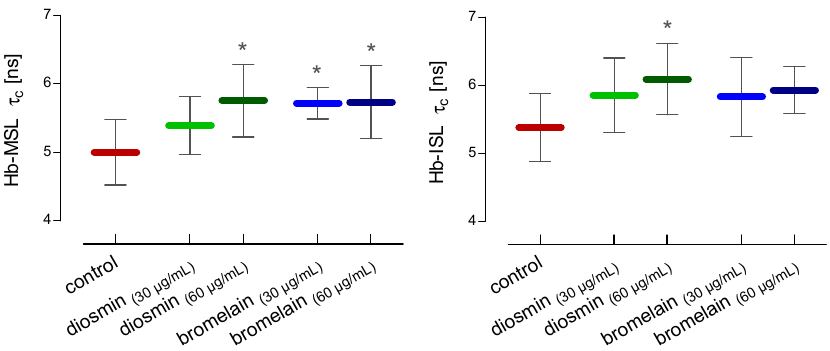
Figure 5. Alterations in the rotational correlation time of MSL and ISL attached to the crude hemoglobin after 24 h of incubation of RBCs with diosmin or bromelain. The data were expressed as mean ± standard deviation, n = 11. Statistical significance: * p < 0.05 vs. control.